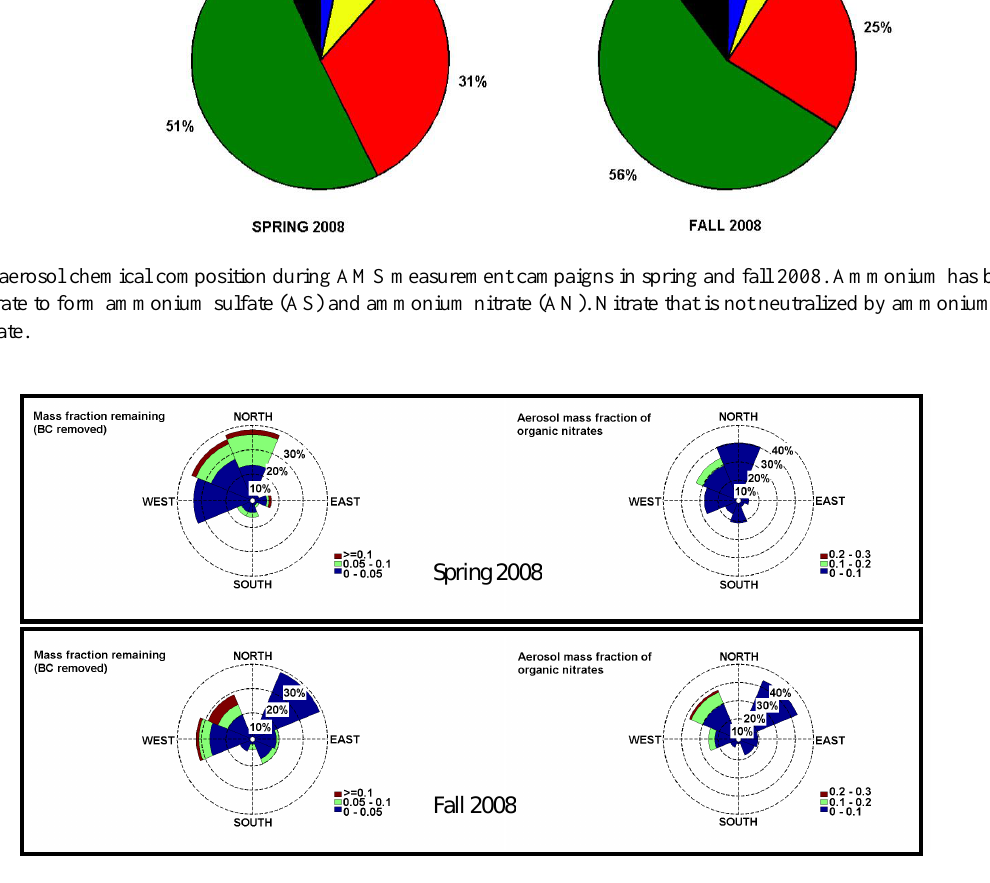
Fig. A2. Wind roses of aerosol mass fraction remaining (MFR non-BC ) after heating to 280 ◦ C and the mass fraction of organic nitrates during AMS measurement campaign in spring 2008 (upper panel) and in fall 2008 (lower panel). The colors represent the mass fractions, and the percent values correspond to the amount of data from each wind direction bin. In fall 2008 aerosol organic nitrate mass fraction and MFR non-BC at 280 ◦ C were correlating. Table A1. Absorption mass cross-sections, σ abs,0 (from the manufacturer) and σ abs (calculated based on Petzold and Sch¨onlinner, 2004), and C parameters for correcting the BC concentrations measured with an aethalometer. C factors given are determined from Hohenpeissenberg data (Collaud-Coen et al., 2010) but because of the similar forest environment, these factors were assumed to describe the Hyyti¨al¨a aerosol